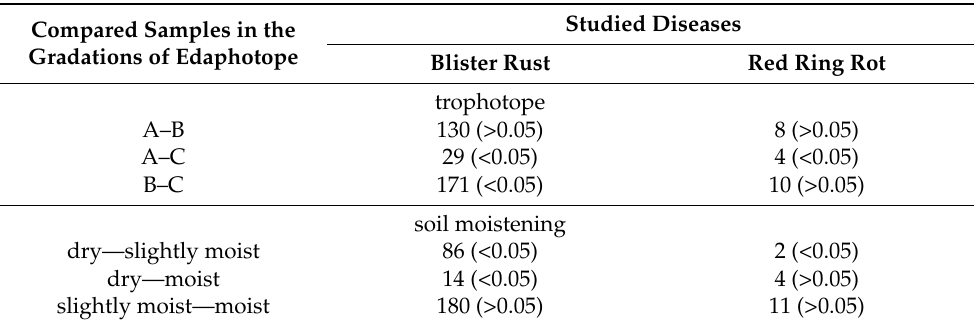
Figure 3. Disease infection rate in surveyed pine forests under different soil fertility (trophotope) and soil moisture. A: pine barrens, B: pine forests growing on relatively nutrient-poor soils, C: mixed forests growing on relatively nutrient-rich soils. Data are the mean values ± standard error. Table 4. Assessment of differences in the disease infection rate in surveyed pine forests under dif- ferent gradations of edaphotope (the Mann–Whitney U test ( p -value)). A: pine barrens, B: pine for- ests growing on relatively nutrient-poor soils, C: mixed forests growing on relatively nutrient-rich soils.